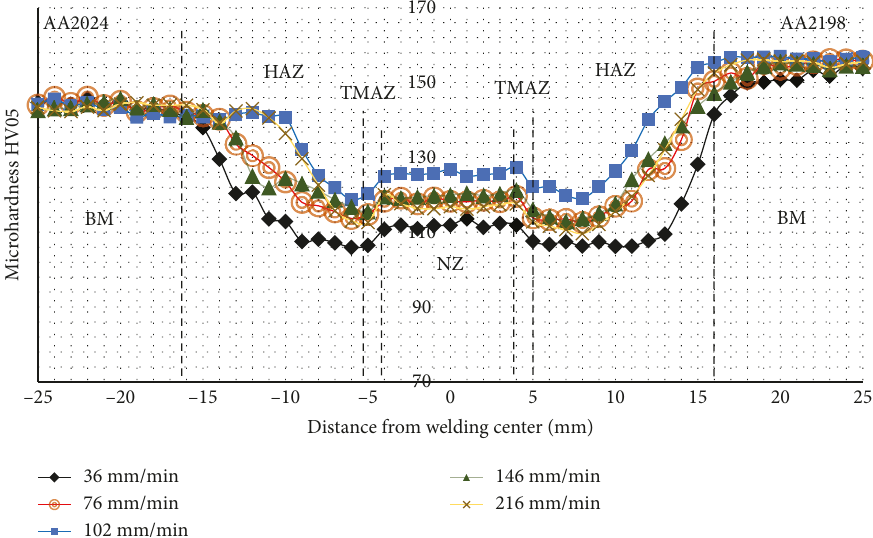
Figure 7: Microhardness values of double-sided friction stir welding